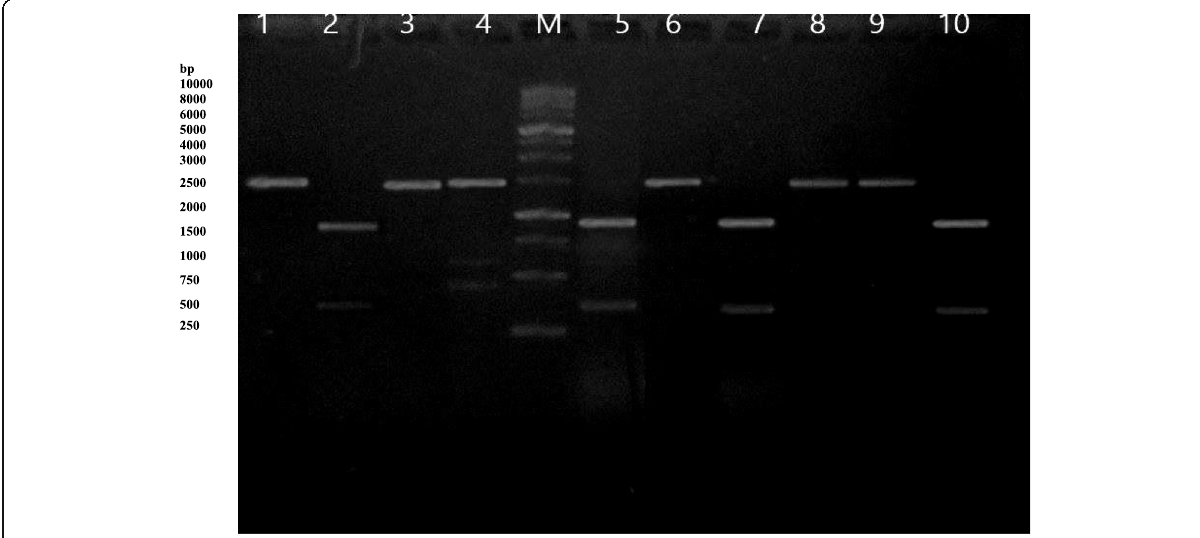
Fig. 3 RFLP patterns of OmpH DNA after digestion with restriction enzyme Bgl II. Lanes 1 – 10 PCR product and M 1kbp DNA